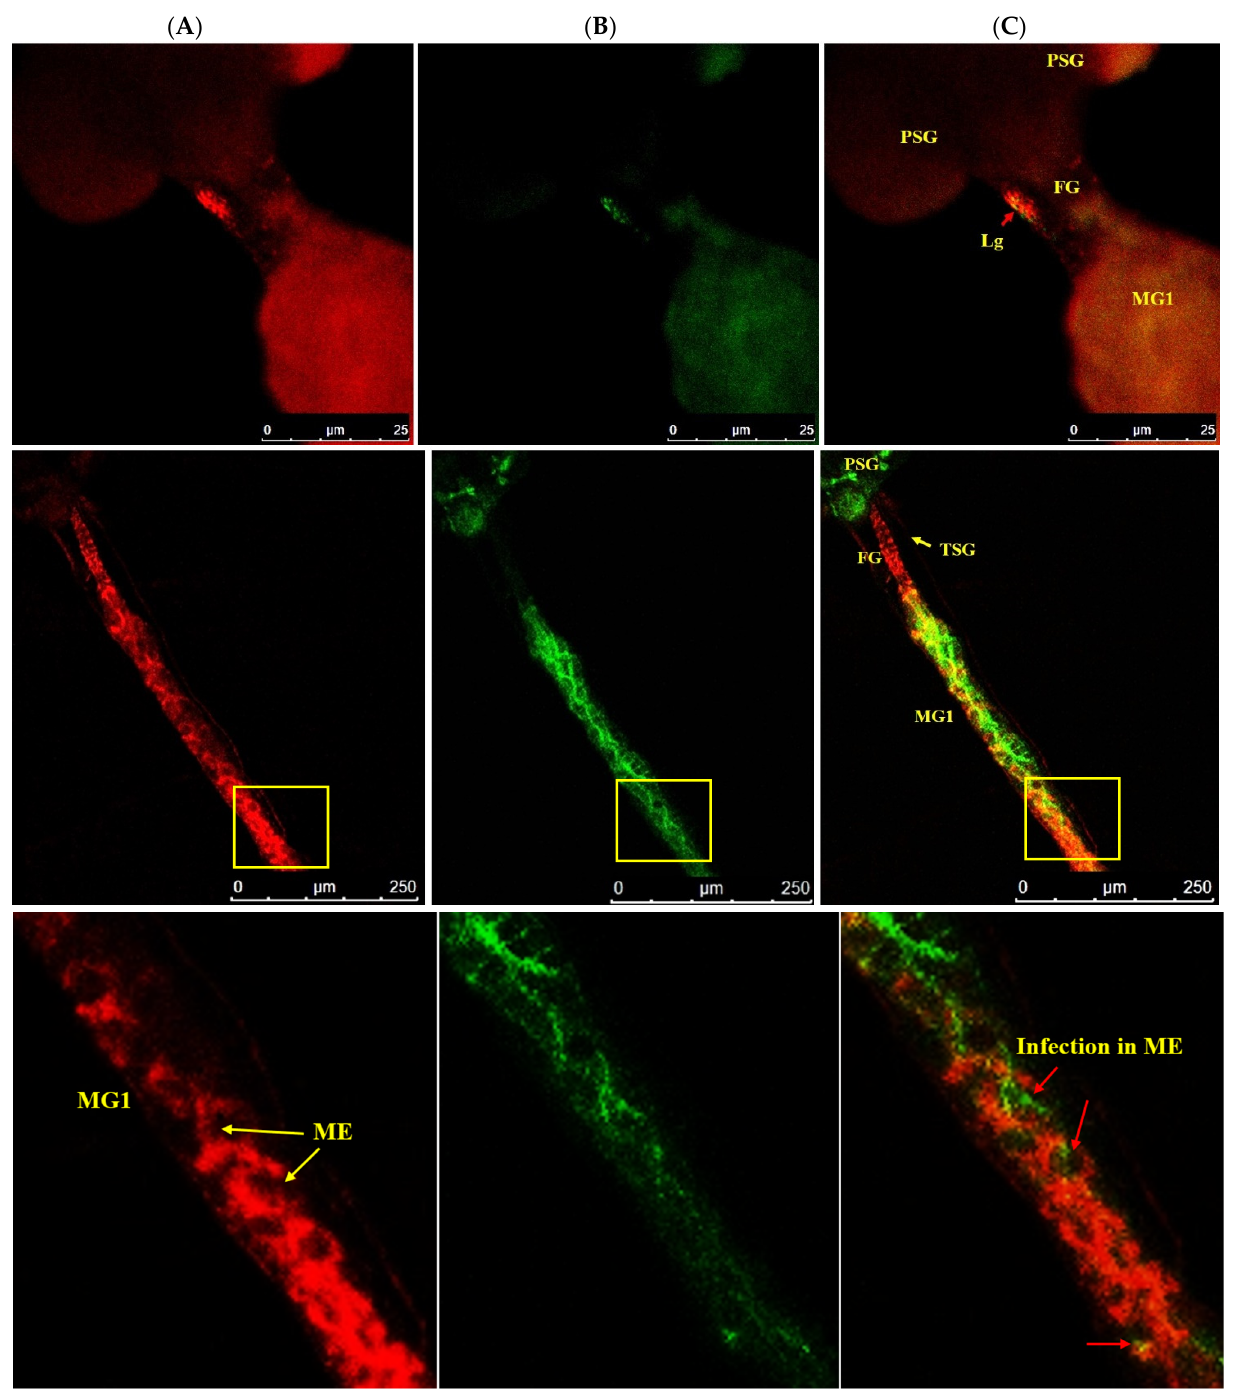
Figure 4. Accumulation of WBNV in ligaments of T. palmi during L1. ( A ). Alexa Fluor 594 phalloidin-conjugated F-actin probe red fluorescence ( B ). FITC-conjugated goat anti-rabbit secondary antibody green fluorescence indicating WBNV-N protein ( C ). Merged image of red and green fluorescence signals. FG—foregut; MG1—midgut 1; ME—epithelial-like cells of midgut (yellow arrows, bottom panel); Lg—ligament (red arrow, top panel); PSG—principal salivary gland; TSG—tubular salivary gland (yellow arrow, middle panel). WBNV infection was detected in ligaments connecting MG1 to PSG 12 h post acquisition (top panel). TSG was not infected by WBNV during the L1 stage indicated by the absence of the green fluorescence signal (middle panel). Panels marked with yellow boxes are enlarged in the bottom panel. Epithelial-like cells in MG1 are marked by yellow arrows (bottom panel). Infection of WBNV (red arrows) in epithelial-like cells of MG1 was seen in L1 12 h post